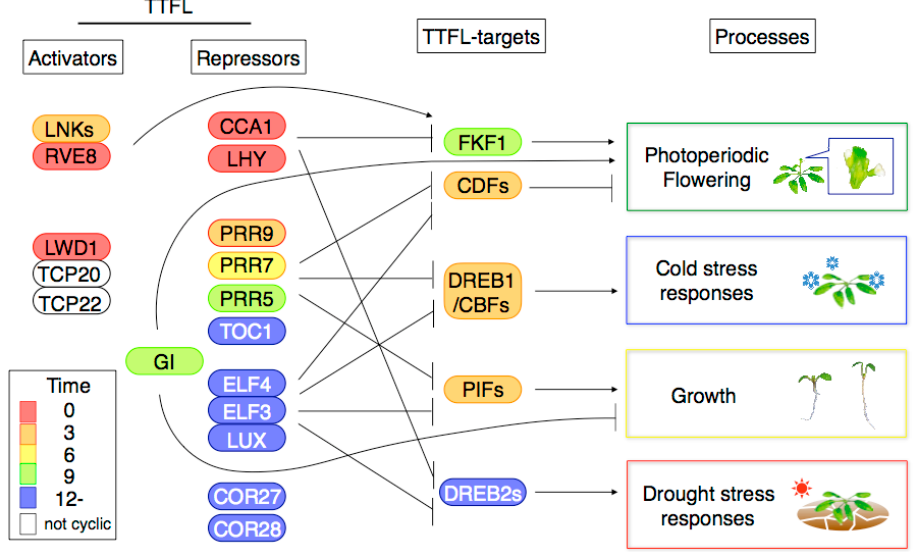
Figure 1. A model of the transcriptional network of the Arabidopsis circadian clock. The clock transcription–translation feedback loop (TTFL) regulates biological processes through regulating key genes (TTFL-targets). Interactions within the clock TTFL are not shown. ‘Time’ is the peak time for mRNA expression under 12 h light / 12 h dark conditions in DIURNAL [105]. Other TTFL-targets are detailed in the text.